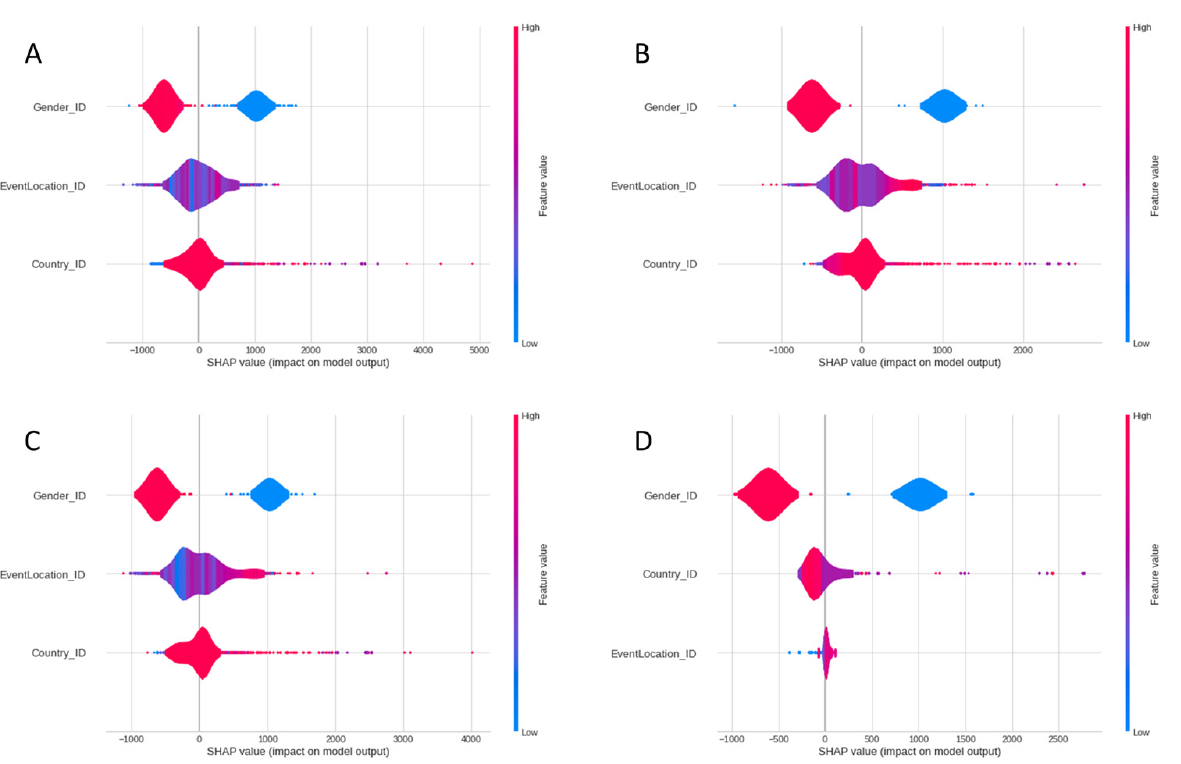
Figure 2. Aggregated SHAP values of the five predictive models: ( A ) Algorithm Random Forest